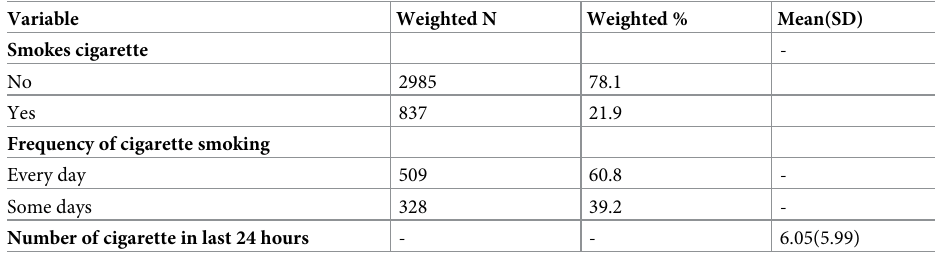
Table 2. Prevalence and patterns of cigarette smoking (N =